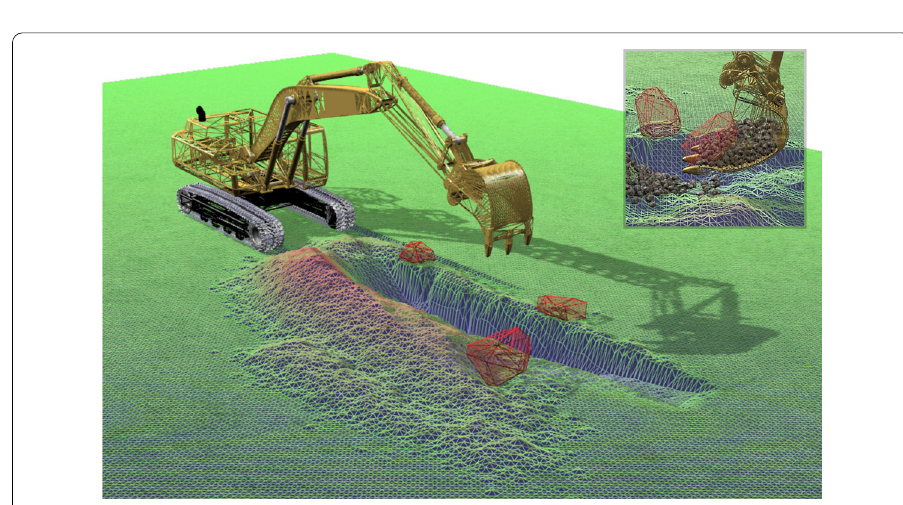
Fig. 23 Demonstration interaction with other rigid bodies (red rocks) while digging a trench with a tracked excavator. See the Additional file 7: Video S7